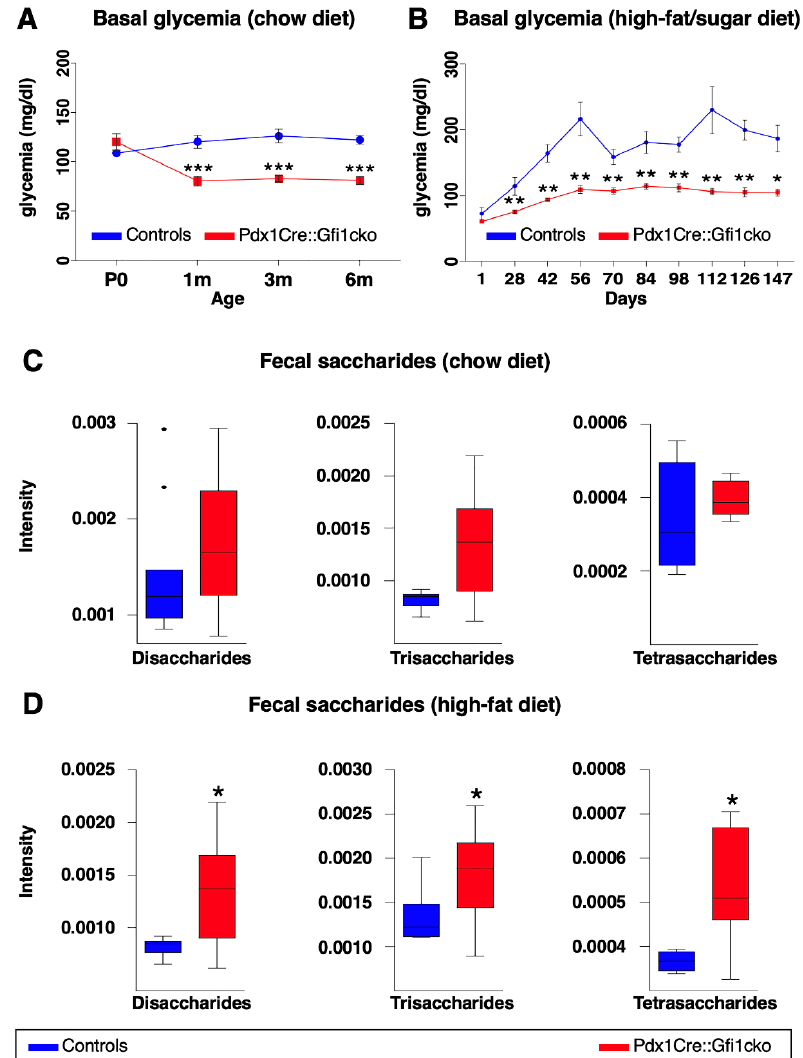
Figure 6. Pdx1Cre::Gfi1cko mice are resistant to high-fat/high-sugar diet-induced hyperglycemia. Basal glycemia was assessed in control and Gfi1 -deficient mice ( n = 8) at different ages. (*** p < 0.001) ( A ). Control and Gfi1 mutant mice were fed with HFCD ( n = 7 animals per genotype) and their glycemia was monitored for 5 months. (* p < 0.05, ** p < 0.01) ( B ). Semiquantitative assessment of fecal saccharides by mass spectrometry was performed using samples of Pdx1Cre::Gfi1cko mice and controls fed with chow diet ( C ) and HFCD ( D ). (chow diet, n = 11 for control and 16 for Pdx1Cre::Gfi1cko samples; HFCG, n = 5 for control and 12 for Pdx1Cre::Gfi1cko samples) (* p <